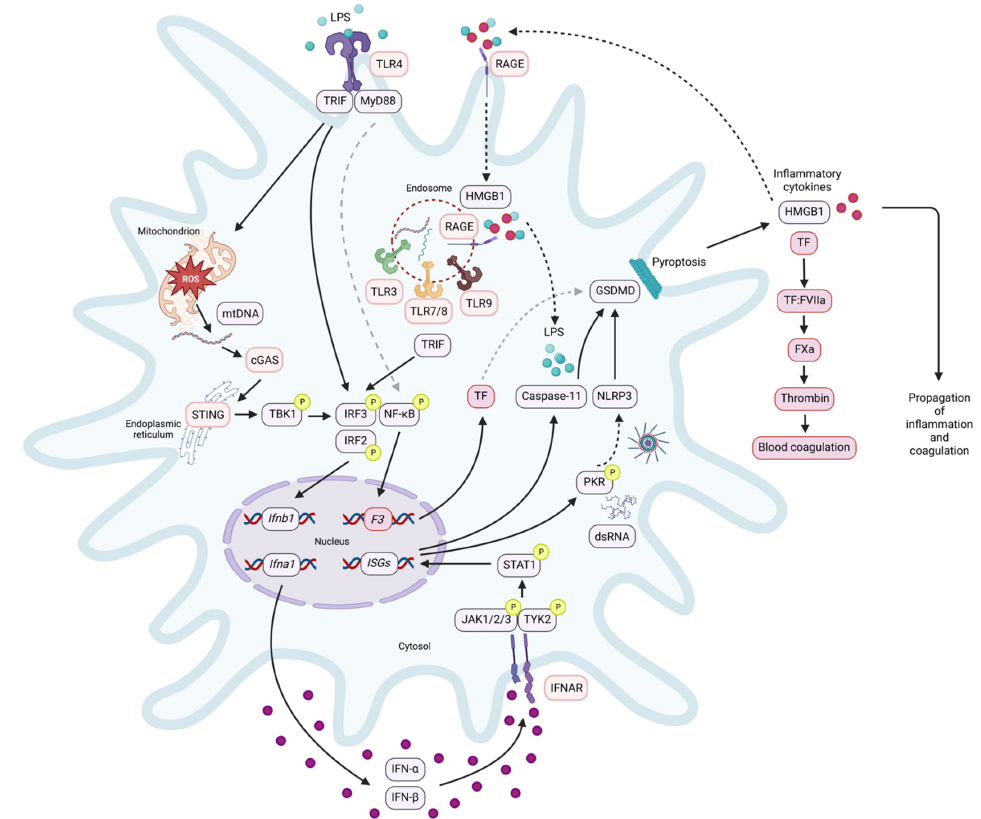
Figure 1. Type I interferons as drivers of blood coagulation. Activation of innate immune cells occurs upon detection of PAMPs (such as LPS) by PRRs (such as TLR4). This rapidly induces type I IFNs via TRIF or NF- κ B. The cytosolic PRR cGAS-STING can also induce type I IFNs upon detection of dsDNA, which can be released from hyperpolarized mitochondria. This results in the release of IFN- α and IFN- β , which act via their receptor IFNAR to induce hundreds of ISGs. Whilst this is a potent and necessary host anti-viral response, excessive type I IFN production can trigger excessive blood coagulation, particularly following Gram-negative bacterial infection. Caspase-11 and PKR, which are ISGs, trigger pyroptosis via inflammasome activation. This releases proinflammatory and procoagulant cytokines, including TF, the initiator of the extrinsic pathway of coagulation. HMGB1 is also released and can physically bind with LPS to activate RAGE. Internalization of HMGB1-LPS may trigger further induction of type I IFNs via activation of endosomal TLRs, potentially amplifying the associated inflammation and